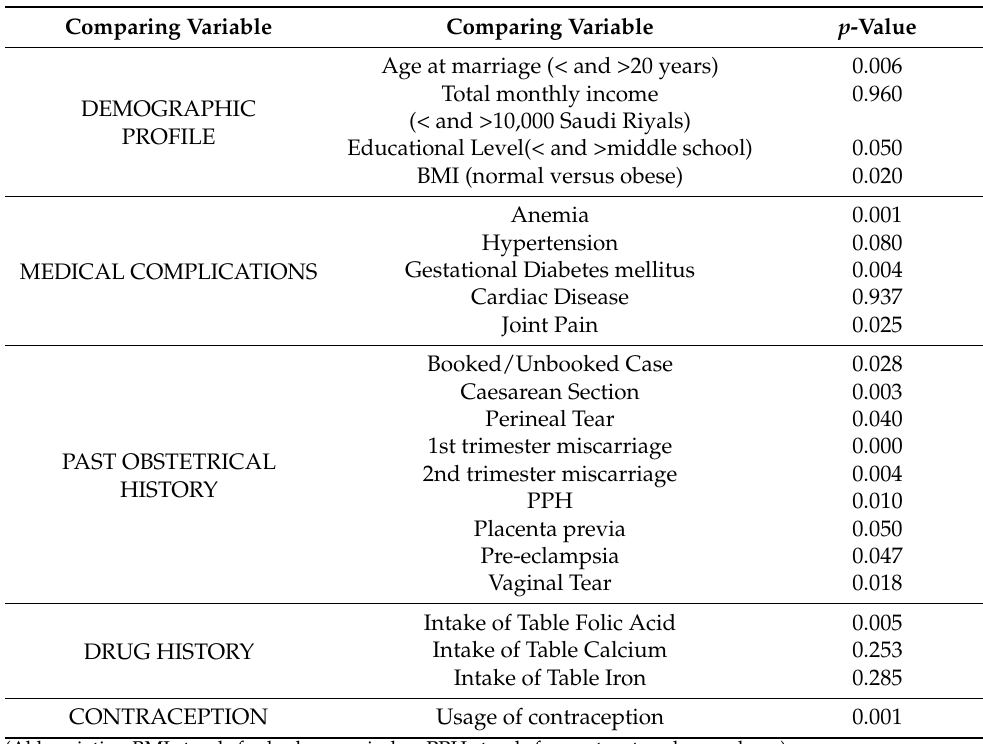
Table 3. Association between women of low parity and high parity with respect to demographic profile, medical history, past obstetrical history, drug history, and contraception (application of Chi-Square test keeping the level of significance ≤ 0.05).